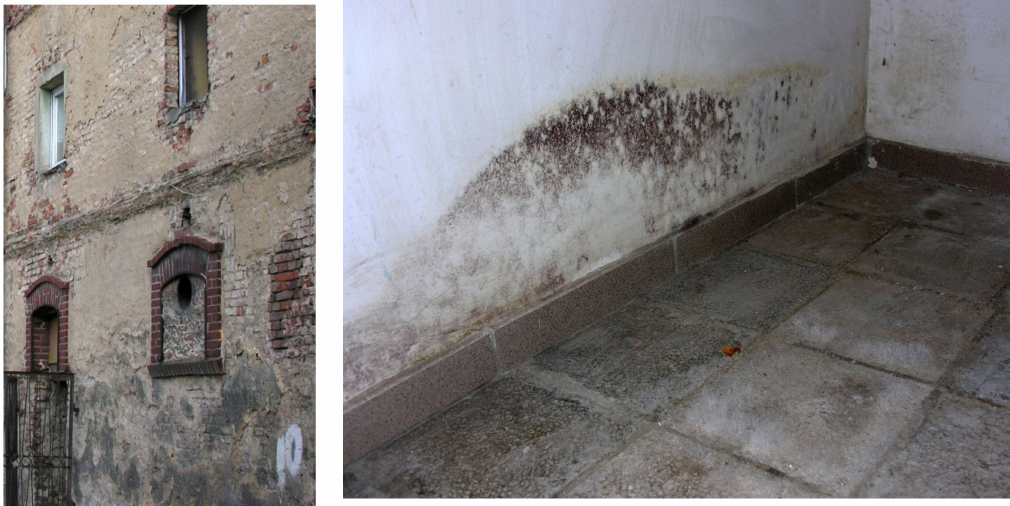
Figure 4. Photographs of selected fragments of a former farm building in Katy Wroclawskie.